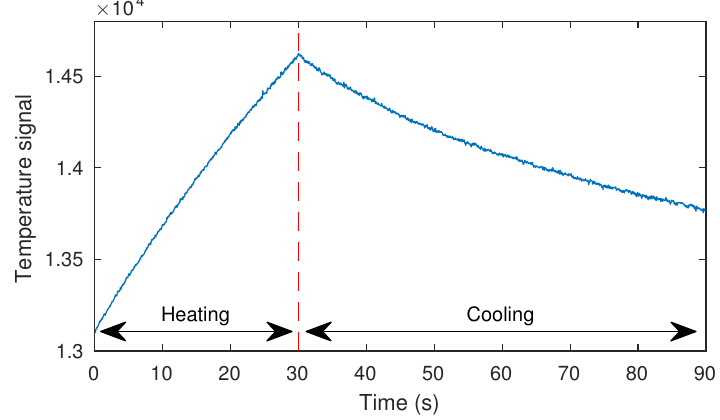
Figure 9. Periods of time considered for the